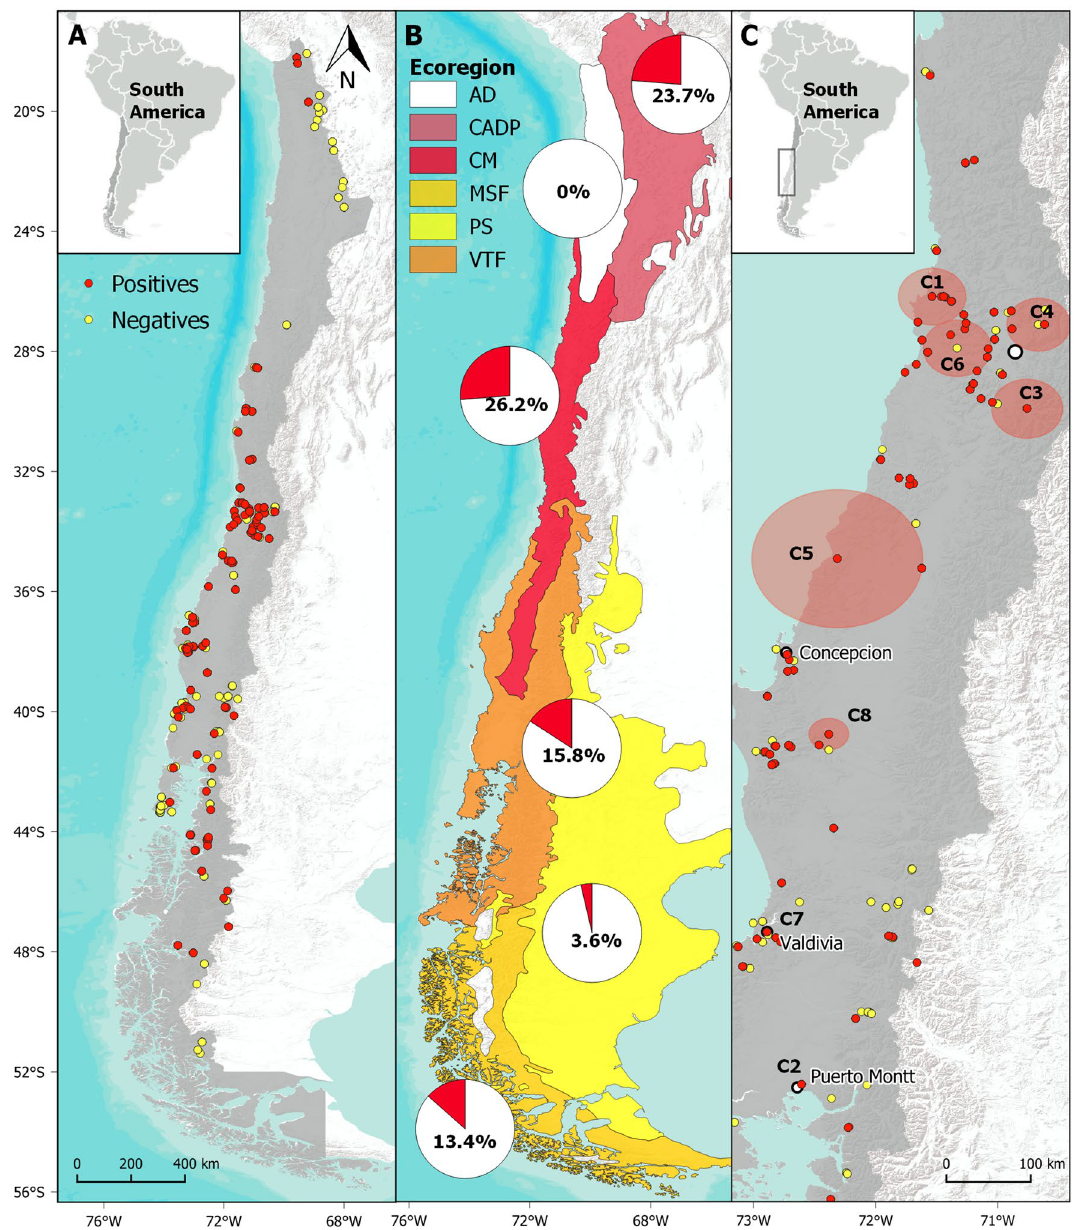
Figure 1. Spatial distribution of Batrachochytrium dendrobatidis ( Bd ) infection in amphibian populations in Chile studied from 2008 to 2018. ( A ) Bd -positive (red dots) and Bd -negative (yellow dots) sites. ( B ) Proportion of Bd -positive amphibians (red portion of pie chart) according to ecoregions: Chilean Andean Dry Puna (CADP), Atacama Desert (AD), Chilean Matorral (CM), Valdivian Temperate Forest (VTF), Patagonian Steppe (PS) and Magellanic Subpolar Forest (MSF). ( C ) Eight statistically significant ( P < 0.05) spatial clusters of Bd high-risk areas (C1 to C8) obtained from scan statistics analysis. All clusters were located in central and south Chile. Most clusters are represented by red shaded circles, apart from C2 and C7 which were smaller in size. Maps and rasters were generated using QuantumGIS v.3.8.2 (QGIS Geographic Information System). Open Source Geospatial Foundation Project. http:// qgis. osgeo. org